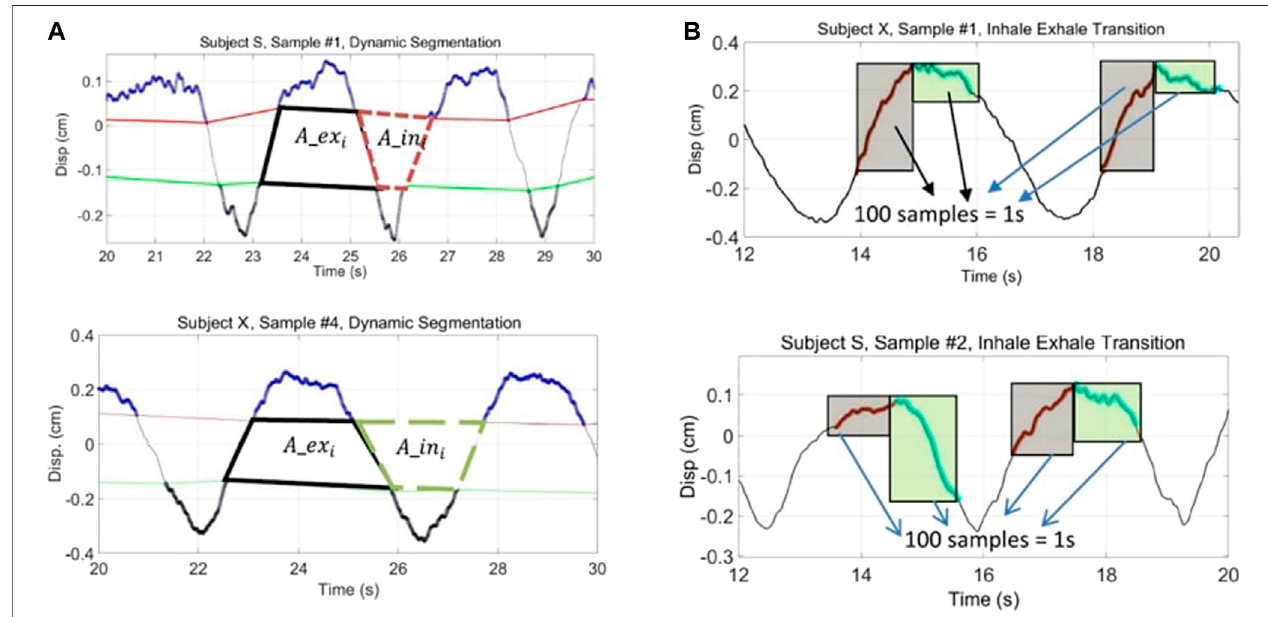
FIGURE 6 | Respiratory pattern classi fi ers used for subject recognition. Dynamically segmented inhale/exhale area ratios of two subjects signi fi cantly differ, (A) , as do signal patterns relating to the dynamics of breathing near the points where the inhale and exhale transition occurs, (B) . From Rahman et al. (2018).